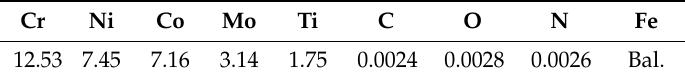
Table 1. Chemical composition of Institute of Metal Research (IMR) steel (wt %). Cr Ni Co Mo Ti C O N Fe 12.53 7.45 7.16 3.14 1.75 0.0024 0.0028 0.0026